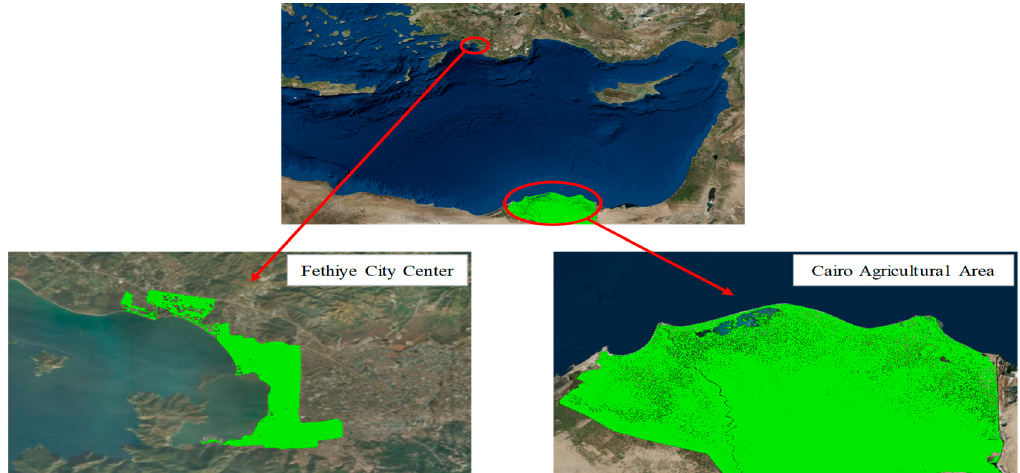
Figure 1. Considered areas for Fethiye City Center, Turkey and Cairo Agricultural Area, Egypt .